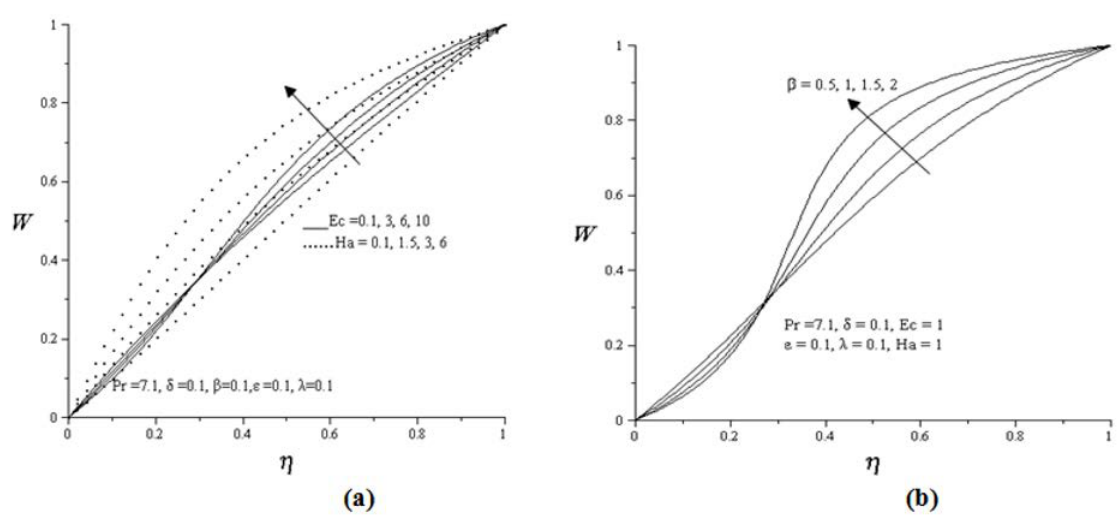
Figure 5. Steady state velocity profiles with increasing Ha , Ec and β